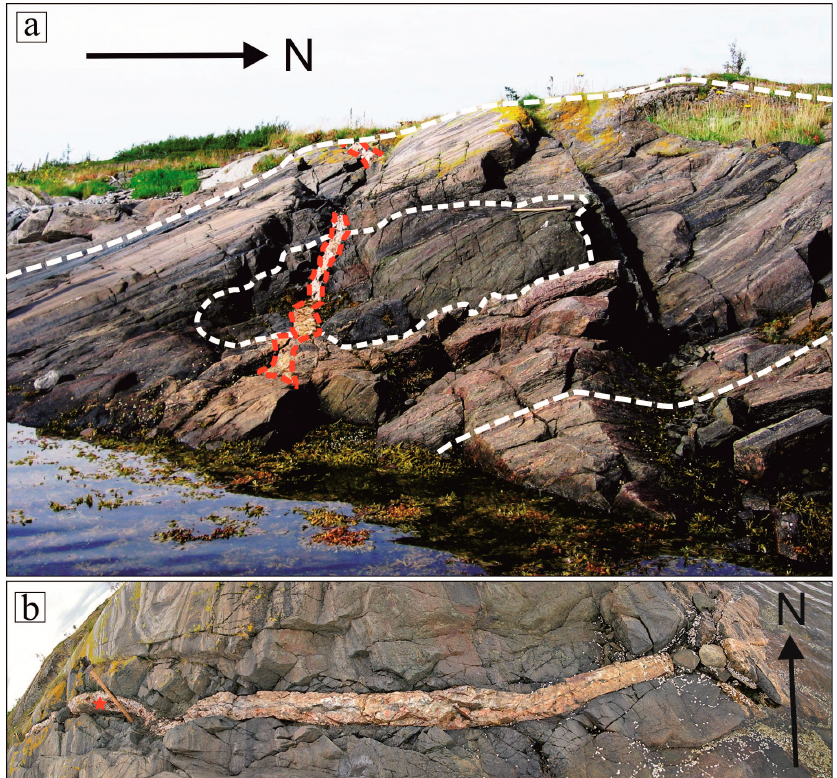
Figure 2. ( a ) West-south-westward view of a boudin composed of banded symplectitic apoeclogite (outlined by outer white dotted line) and eclogite (outlined by inner white dotted line). The boudin is crosscut by a subvertical pegmatite vein (outlined by red dotted line). The enclosing rocks are finely-banded amphibole gneisses showing platy parting. Stolbikha Island, Gridino area. ( b ) pegmatite vein (thickness 20–30 cm); small red star indicates the site from which sample 101d was collected.